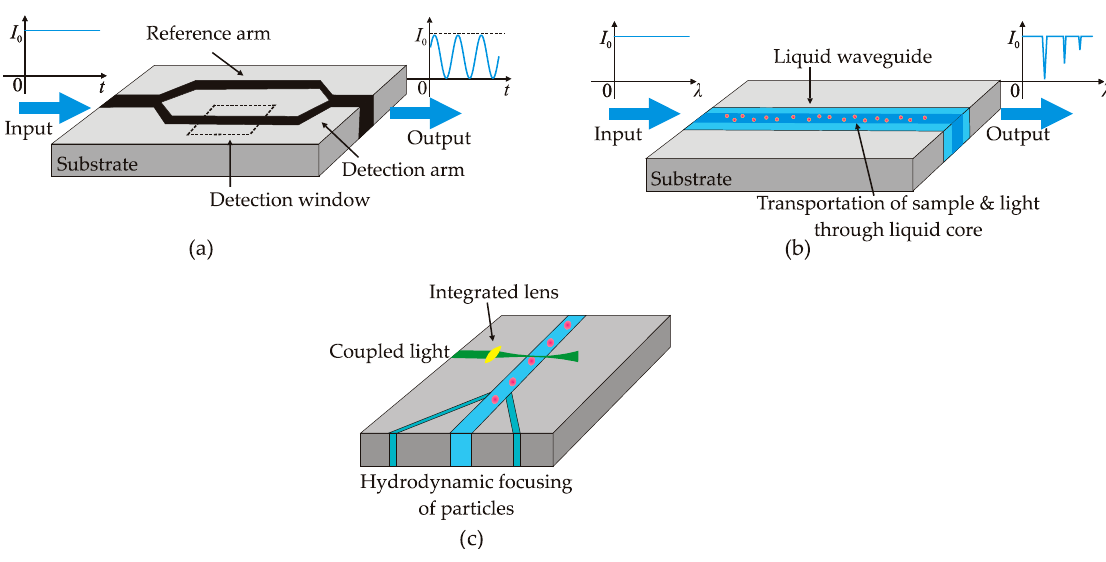
Figure 6. Schematics of functional optofluidic devices: ( a ) integrated Mach–Zehnder interferometer for label-free detection of biochemical sample; ( b ) optofluidic enhanced Raman spectroscopy for analytical chemistry; and ( c ) a typical configuration for optical detection or manipulation of micro-particles.